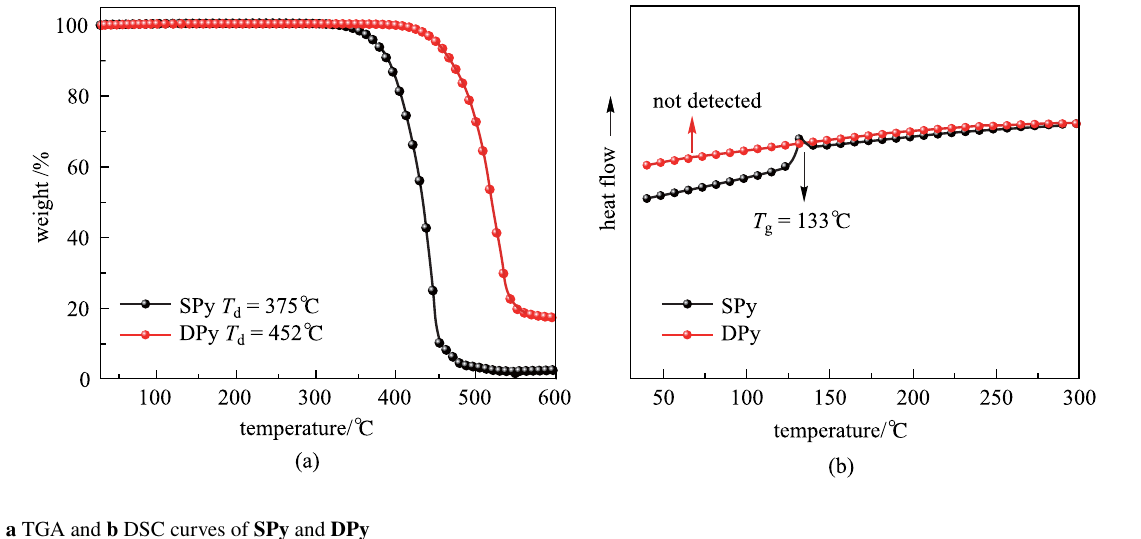
Fig. 2 a TGA and b DSC curves of SPy and DPy Table 1 Thermal, photophysical and energy properties of SPy and DPy